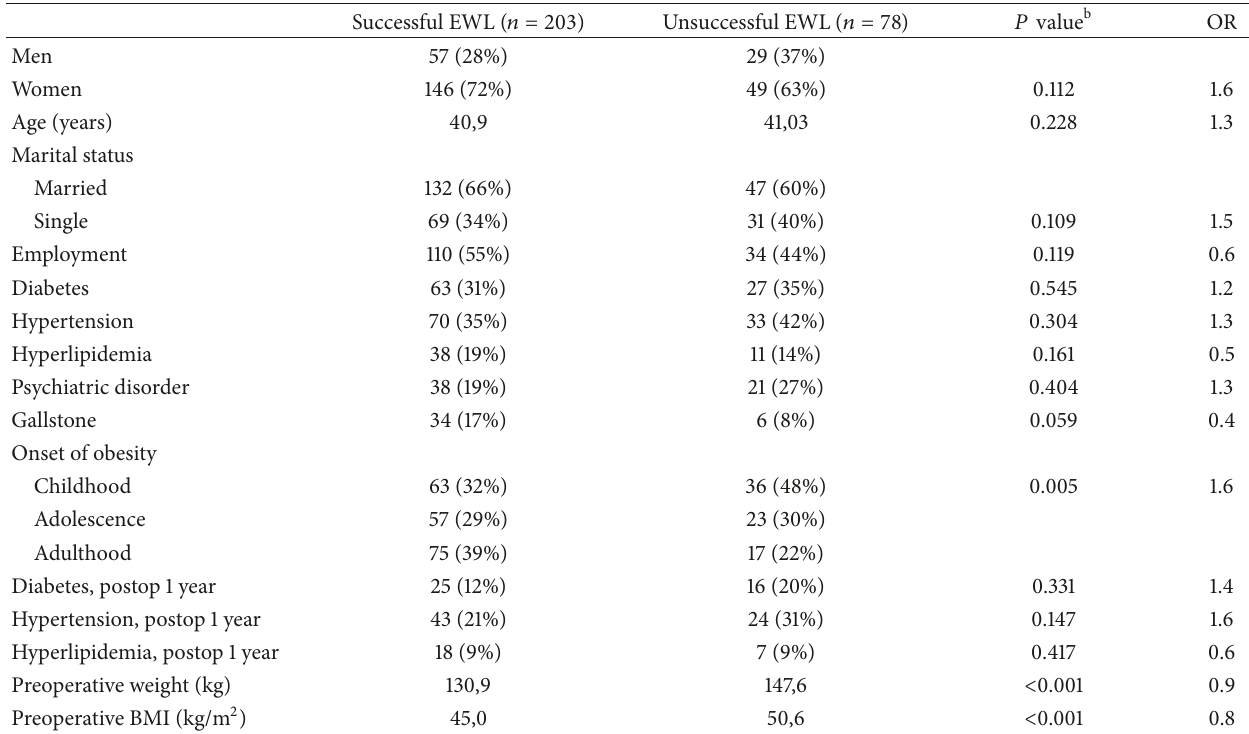
Table 3: Logistic regression analysis correlating preoperative clinical factors and successful versus unsuccessful weight loss in patients following RYGB at 1-year follow-up. Data expressed as 𝑛 (%) for nominal variables or mean for continuous variables. Successful EWL was defined as ≥ 60%; unsuccessful EWL ≤ 59%. b Comparison of successful versus unsuccessful EWL. OR: odds